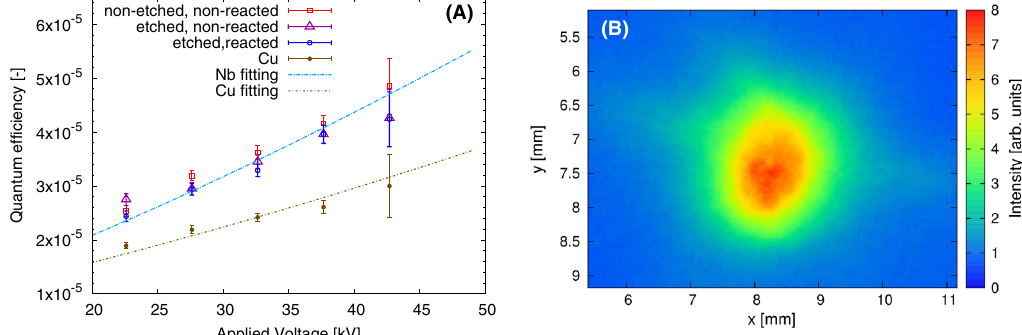
FIG. 7. Experimental results and numerical fit for the low-charge regime. (a) QE versus applied voltage for different cathodes. The numerical calculations for Cu and Nb according to the three-step model are represented by the dashed lines. Fit parameters for Nb are (cid:9) ¼ 4 : 73 eV , (cid:10) ¼ 2000 m (cid:1) 1 , T ¼ 1200 K and for Cu (cid:9) ¼ 4 : 68 eV ; (cid:10) ¼ 1800 m (cid:1) 1 , T ¼ 2000 K . (b) Electron beam profile recorded at SCR2.